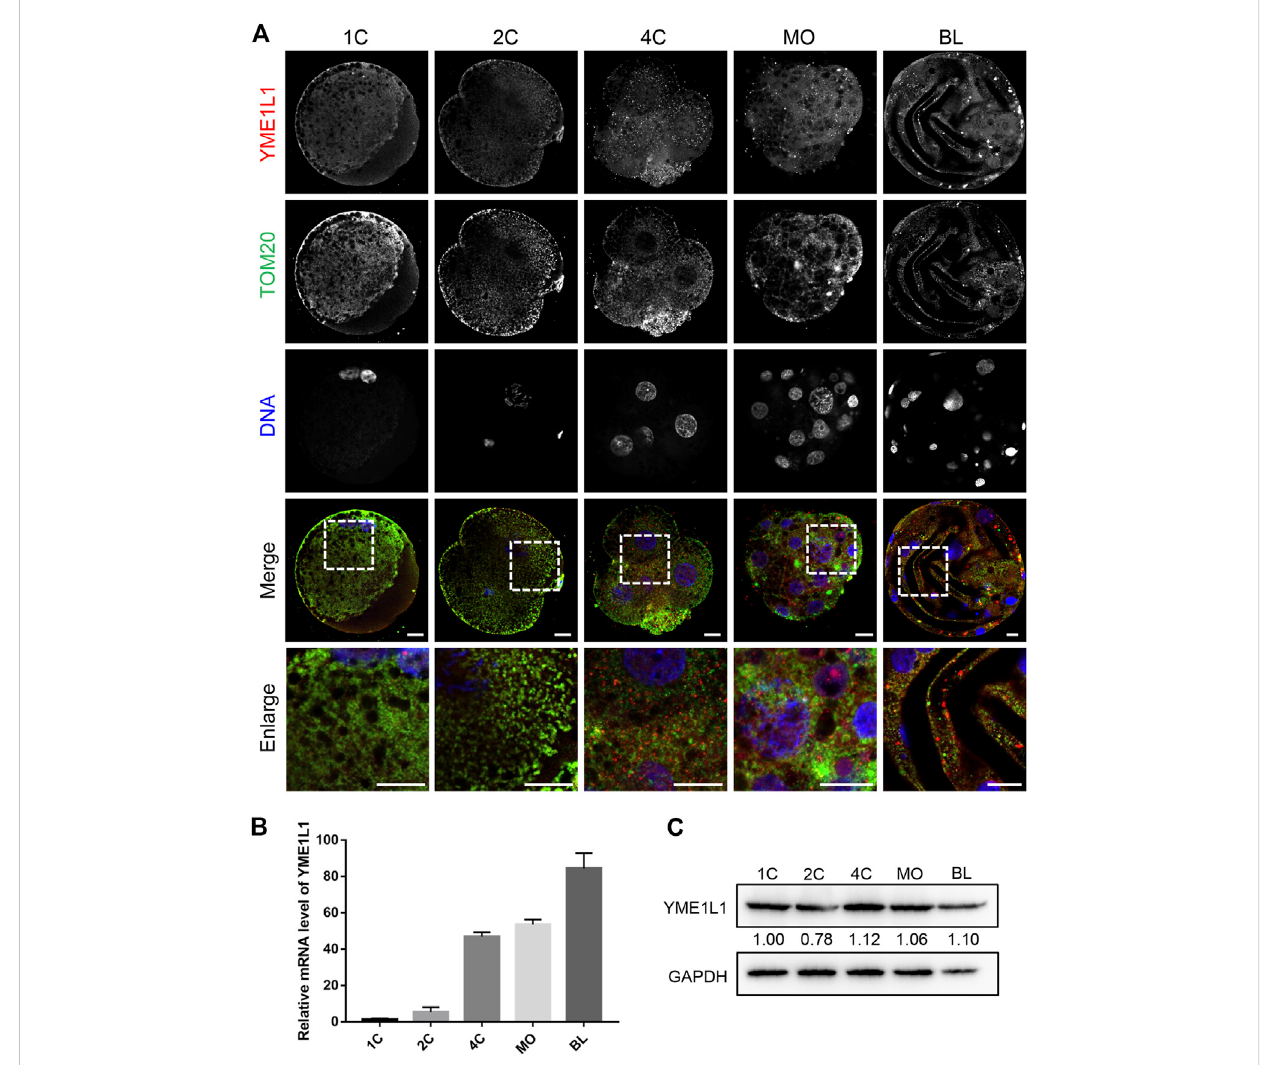
FIGURE 1 Expression of YME1L1 protein and mRNA during embryonic development in pig. (A) Representative confocal immuno fl uorescence images for YME1L1 and TOM20 expression at different stages during embryo development. (B) Quantitative PCR data of YME1L1 relative to the 1-cell